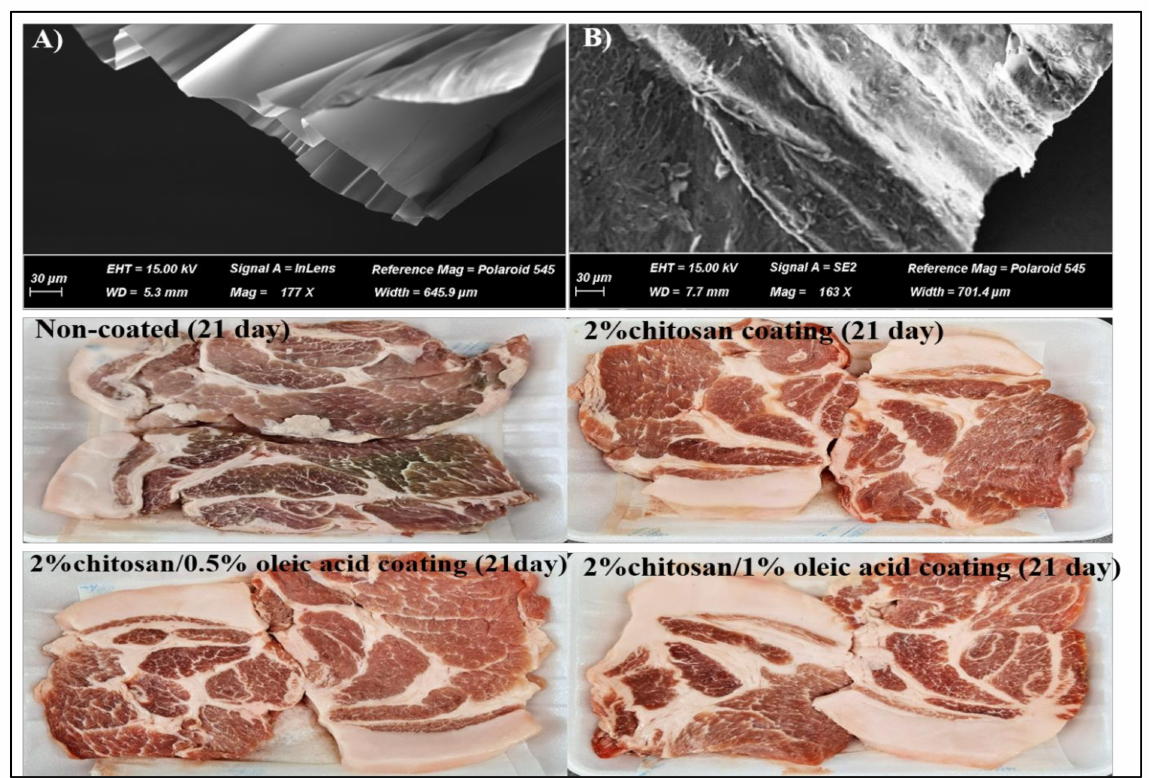
Figure 1. The representative images of the dry form of edible coatings: 2% chitosan ( A ), 1% oleic acid in 2% chitosan ( B ). The non-and coated pork slices wrapped with plastic film were taken on the 21st day of